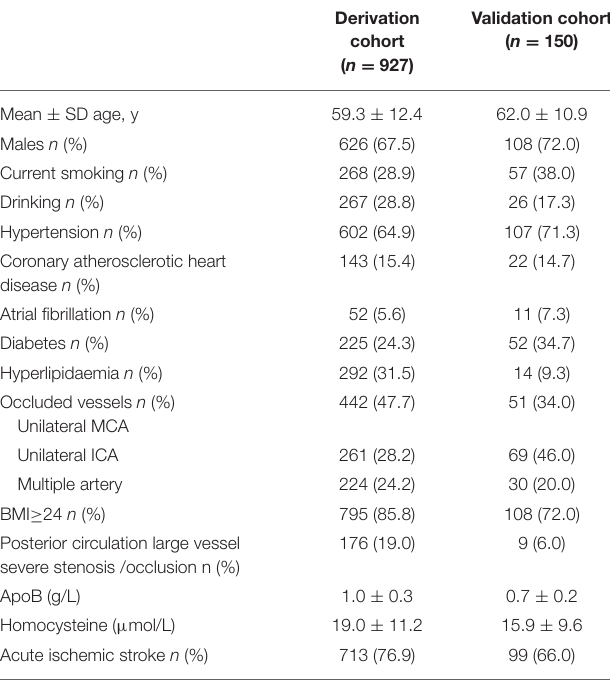
TABLE 2 | Baseline characteristics of patients with first-ever acute ischemic stroke (AIS) caused by anterior circulation large vessel